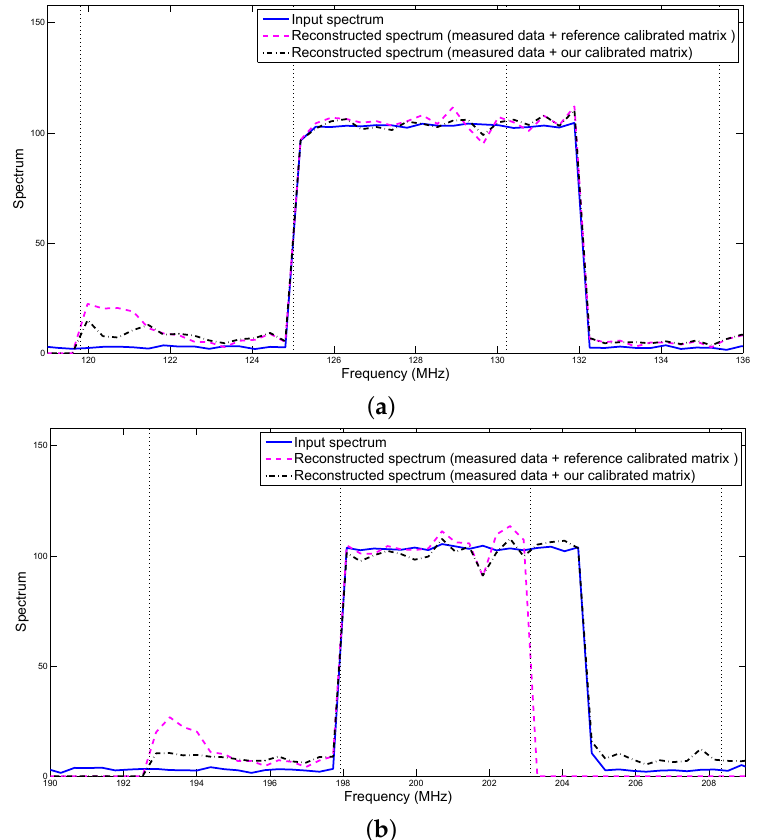
Figure 14. Zoom of Figure 13 between frequency ranges [119;136] MHz and [190;209] MHz. ( a ) Ex- ample of correct reconstruction of transmitter position obtained with both calibration